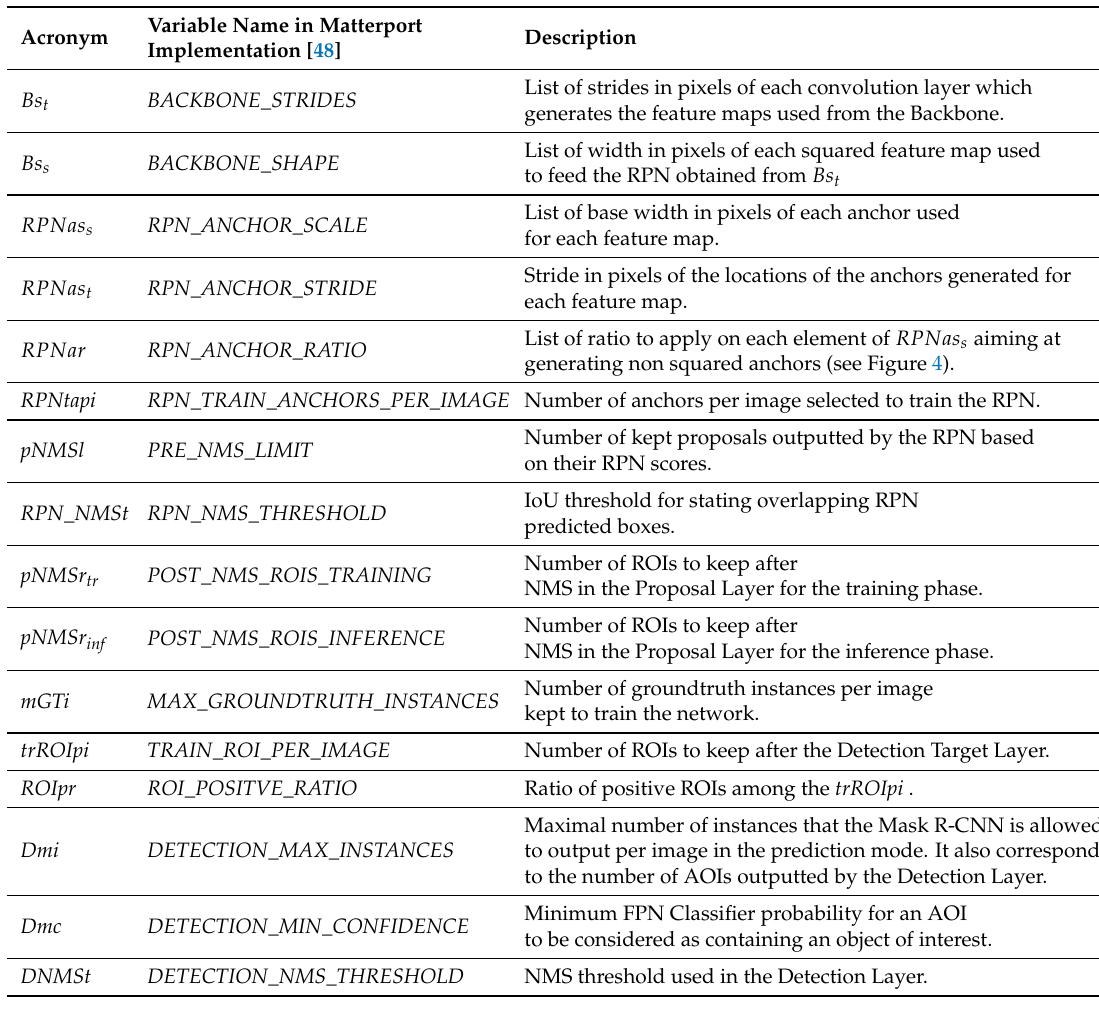
Table A1. Acronyms correspondence with Matterport implementation